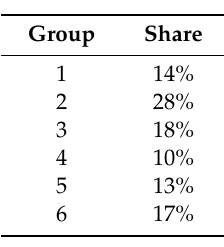
Table 1. Share (or percentage) of charges per hours.